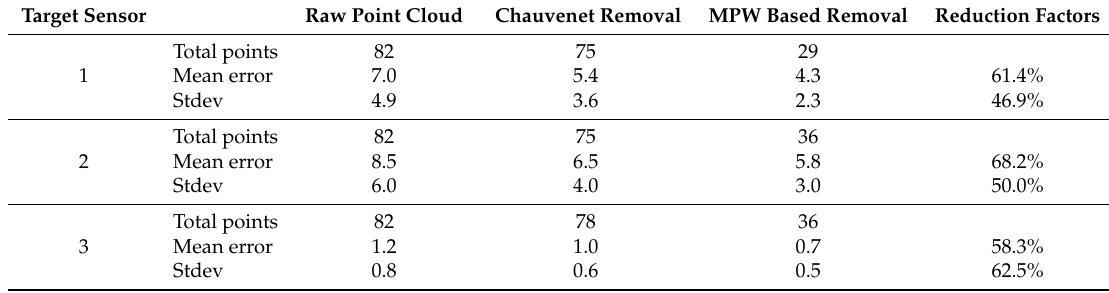
Table 7. Summary of results for the RMS relative error and its associated standard deviation between each sensor and the reference sensor upon outlier removal with Chauvenet criterion and using MPW. Errors are in percent values as well as their respective standard deviations (stdev). The last column shows the reduction factor (final value/initial value) of mean errors and standard deviations from original raw point cloud to the final point cloud purged from outliers. Overall, mean errors and standard deviations for SPW and MPW are similar so only one of them is